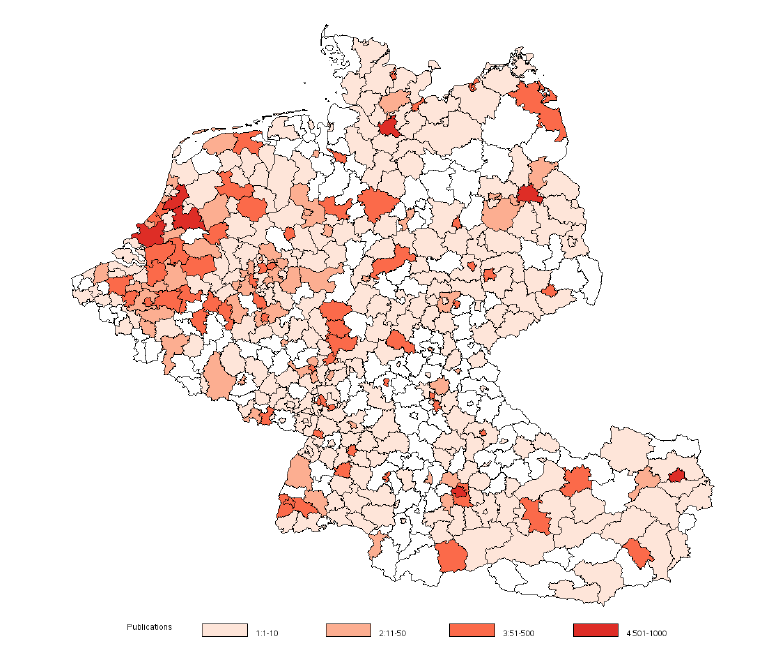
Figure 1a: Publication Output for Cardiovascluar Medical Devices at Regional levels of NUTS-3 in Europe: Netherlands, Belgium, Luxembourg, Germany, and Austria